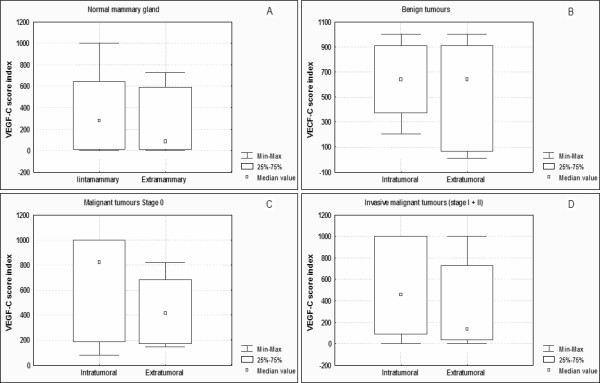
VEGF-C score index in normal mammary gland (A), benign tumours (B), non-invasive (C) and invasive malignant (D) tumours.